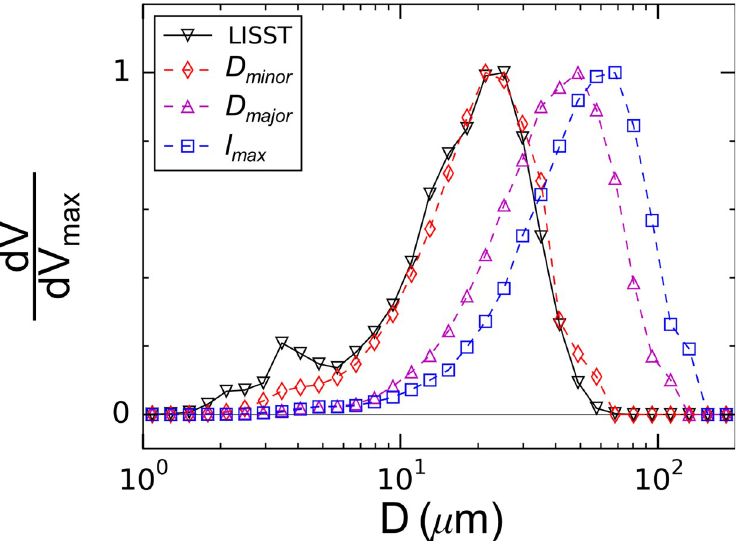
Fig 5. Normalized volume spectra measured with the LISST compared with spectra obtained from the microscope